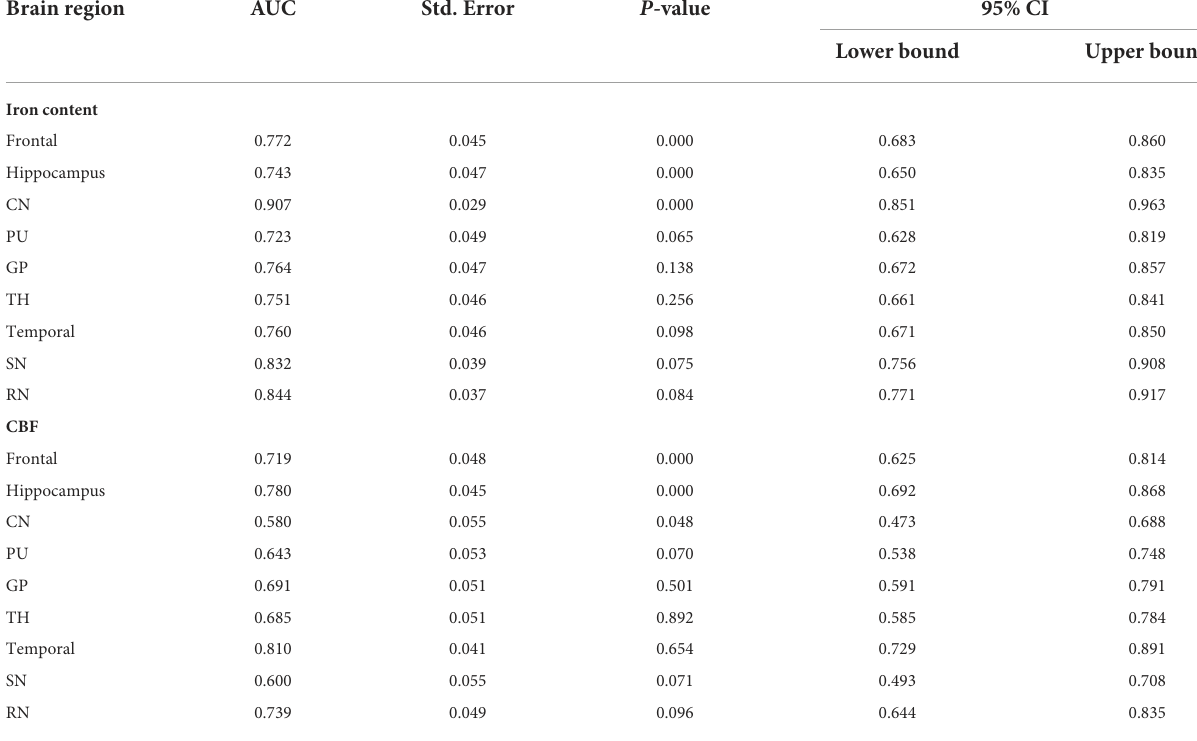
TABLE 4 ROC curve analysis results of iron content/CBF in brain regions of ADHD-ATs children ( n = 102). Brain region AUC